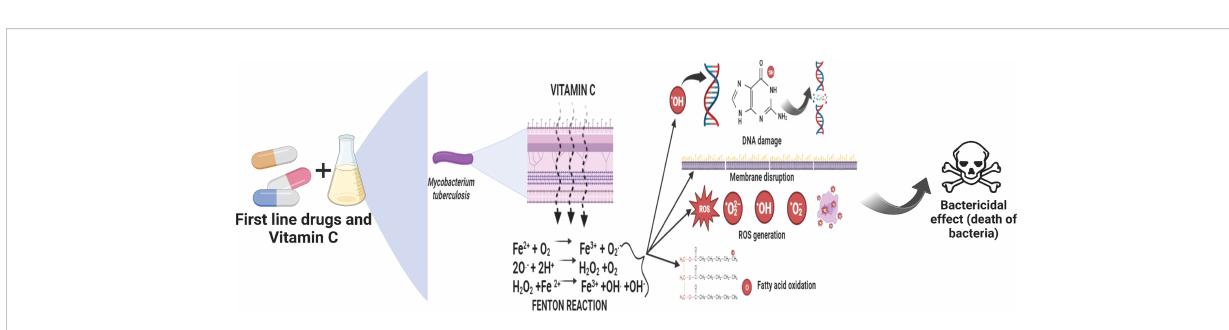
FIGURE 3 Downregulation of genes, playing vital role in helping bacteria to move into latent phase (post VC